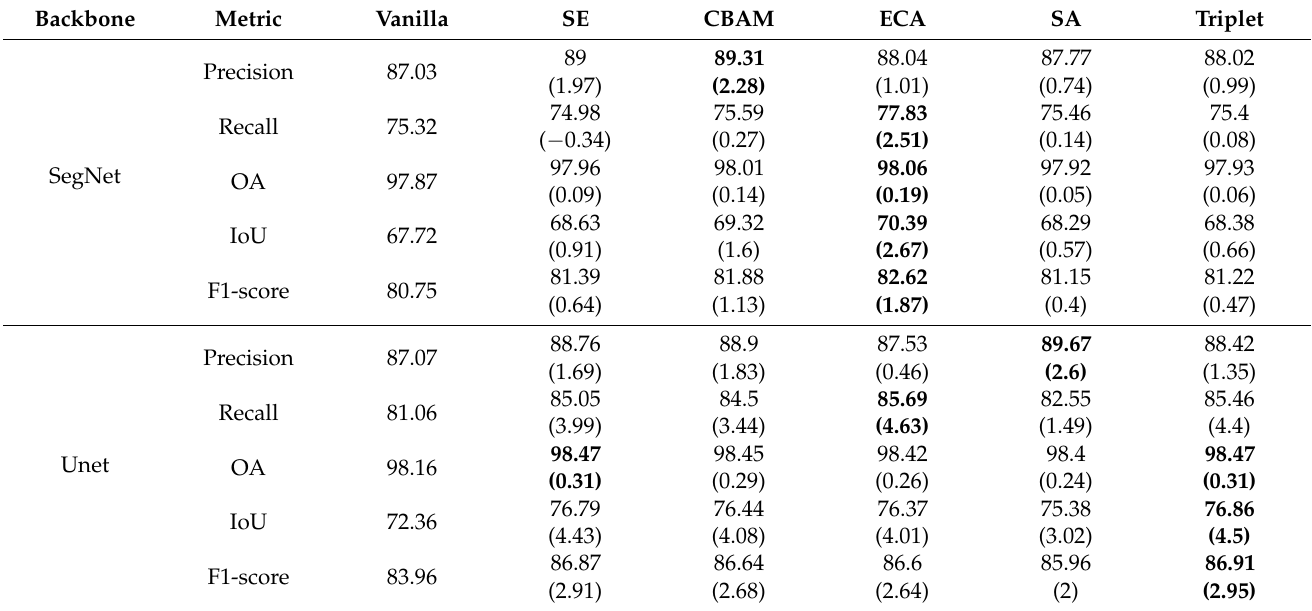
Table 2. Building segmentation with different backbones with different AMs. The best record and improvement in each metric are marked in bold. The numbers in the brackets are the difference between the results of attention-based network and vanilla